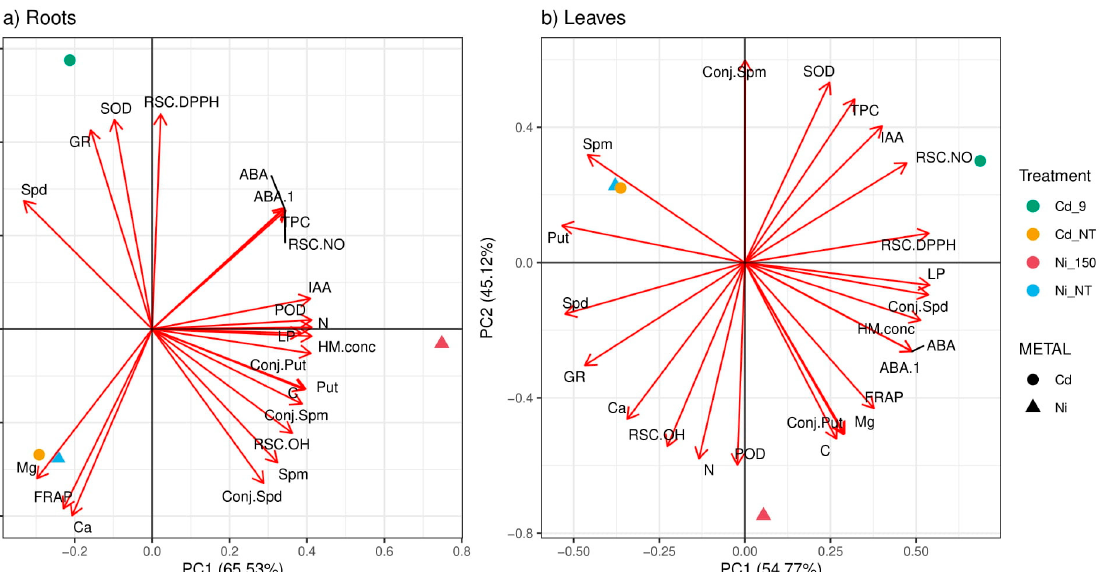
(Figure 5a), parameters associated with PC1 (LP < N < POD < HM conc. < IAA < Put <